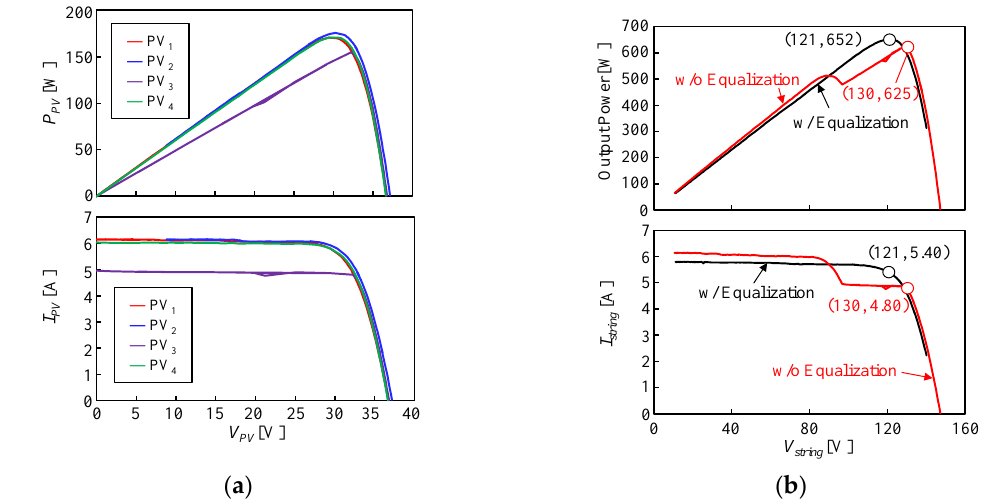
Figure 18. Experimental results of field testing. ( a ) Individual panel characteristics used for experiment; ( b ) Measured string characteristics with/without proposed DPP converter.